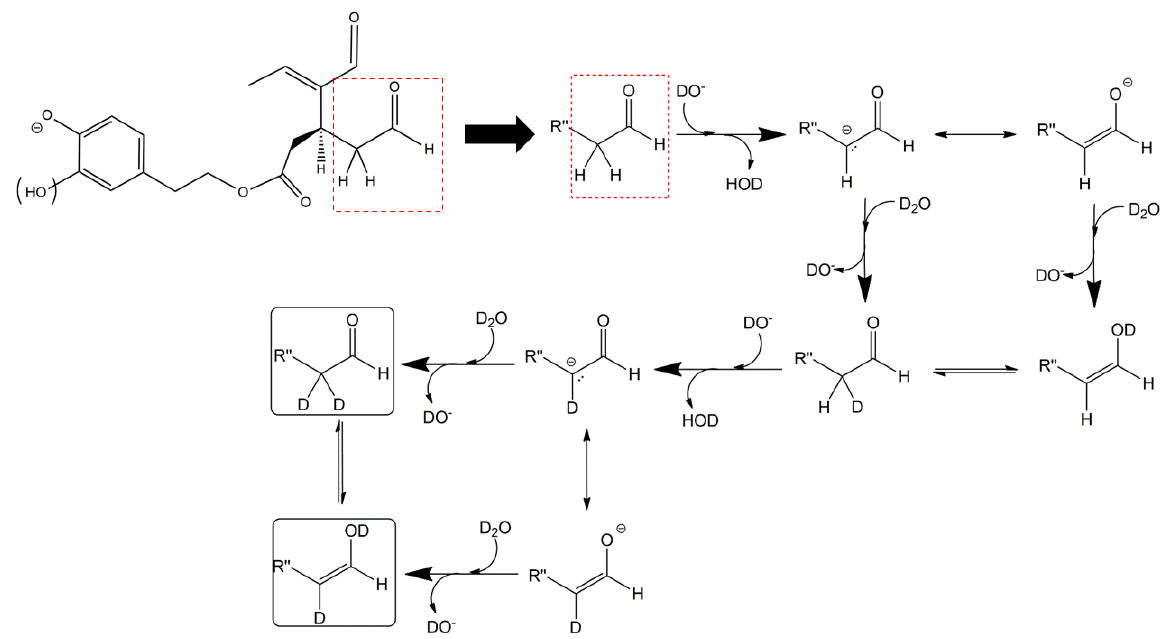
Figure 7. Proposed mechanism explaining the double HDX occurring during the ESI process on the carbon atom(s) adjacent to carbonyl groups of OLEO and OLEA isoforms and not involved in a C=C bond. For the sake of simplicity, the mechanism is shown only for the suitable C=O group present in Open Forms I of the two secoiridoids, although it can also occur on all suitable carbonyl groups of Open Forms II and Closed Forms I (see Table 1). The existence of a tautomeric equilibrium between bis-deuterated aldehydic forms and their enolic counterparts is highlighted A different scenario was hypothesized to explain the XIC chromatogram obtained for the exact m / z value of 306.1426, which corresponds to OLEO anions bearing 3 D atoms on